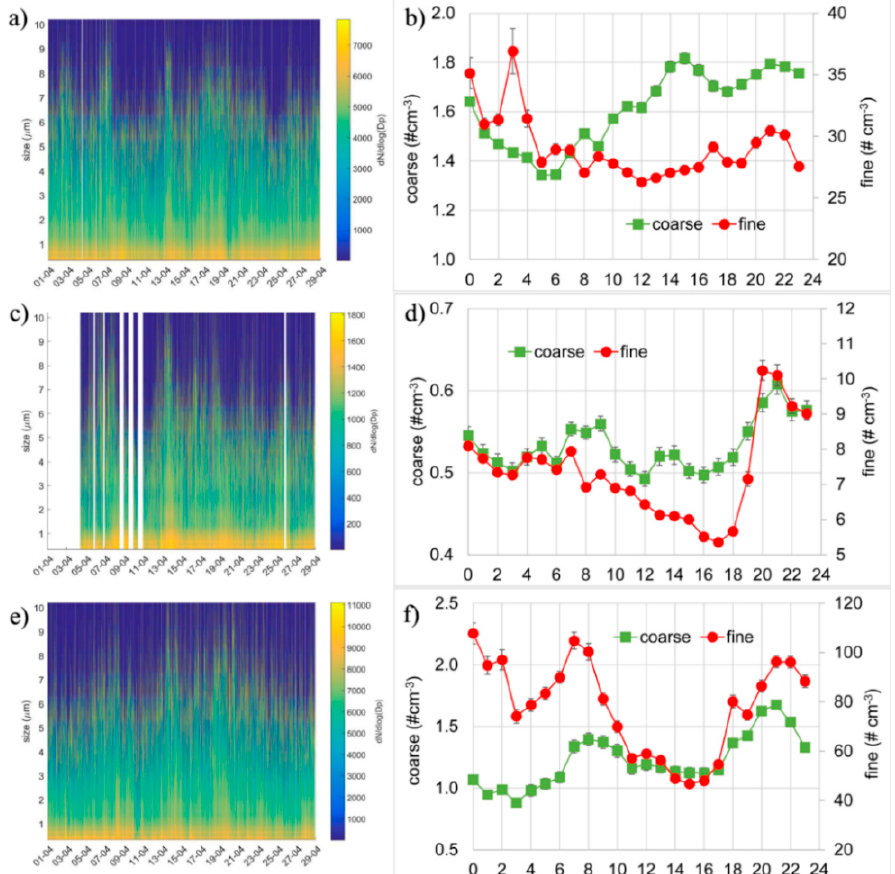
Figure 3. Aerosol size distribution for the ( a ) CGR, ( c ) LMT, and ( e ) ECO stations, respectively (left panels). Diurnal variation (right panels) for fine and coarse particles during the measurement period for ( b ) CGR, ( d ) LMT, and ( f ) ECO stations in local time (UTC + 1). Error bars represent standard error (standard deviation of the mean).